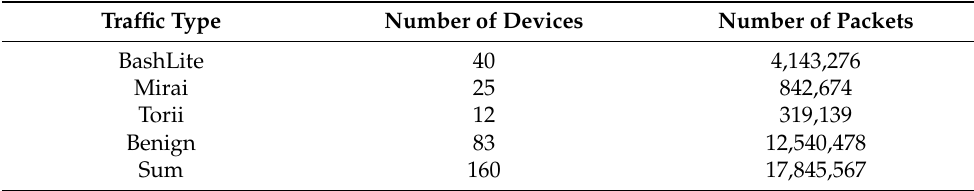
Table 3. Number of packets in dataset according to malware type.